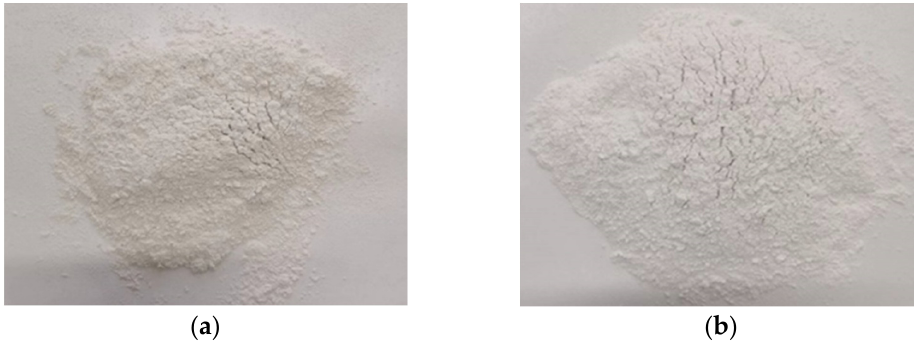
Figure 4. Seashell powder and stratum corneum-exfoliated seashell powder; ( a ) seashell powder; ( b ) Stratum corneum-exfoliated seashell powder. Table 3. Physical characteristics of shell and shell powder.